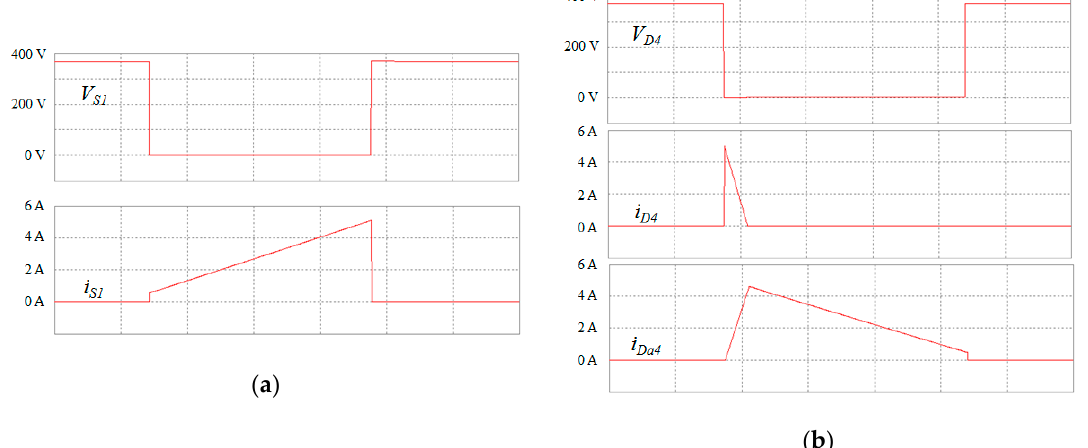
Figure 9. Simulation results of the proposed inverter: ( a ) V S1 and i S1 ; ( b ) V D4 , i D4 , and i Da4 .